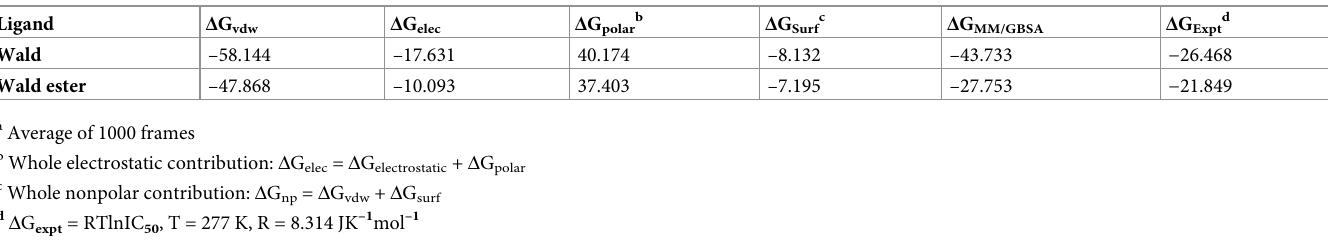
S1 Fig. Ramachandran plot of the optimized S . aureus HK/WalK structure.